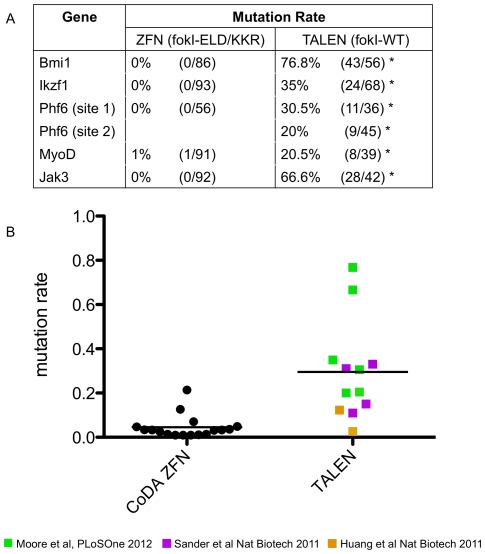
TALENs exhibit high mutation rates.A) Table showing somatic mutation rates of ZFNs and TALENs for five genes. Mutation rate was calculated as number of mutant sequences divided by the total number of sequences analyzed for a given target region. Raw sequence scores are shown in parentheses. Each TALEN had a significantly different mutation rate compared to ZFNs as assessed by Fisher Exact Test (p<0.001 denoted by asterisks). B) Plot of somatic mutation rates of CoDA ZFNs and TALENs in zebrafish [1], [2], [8]. The average mutation rate of all TALENs was higher than that of CoDA ZFNs. ZFNs with mutation rates of 0% were excluded from this analysis. Datum points of TALENs from different research groups are distinguished by color.